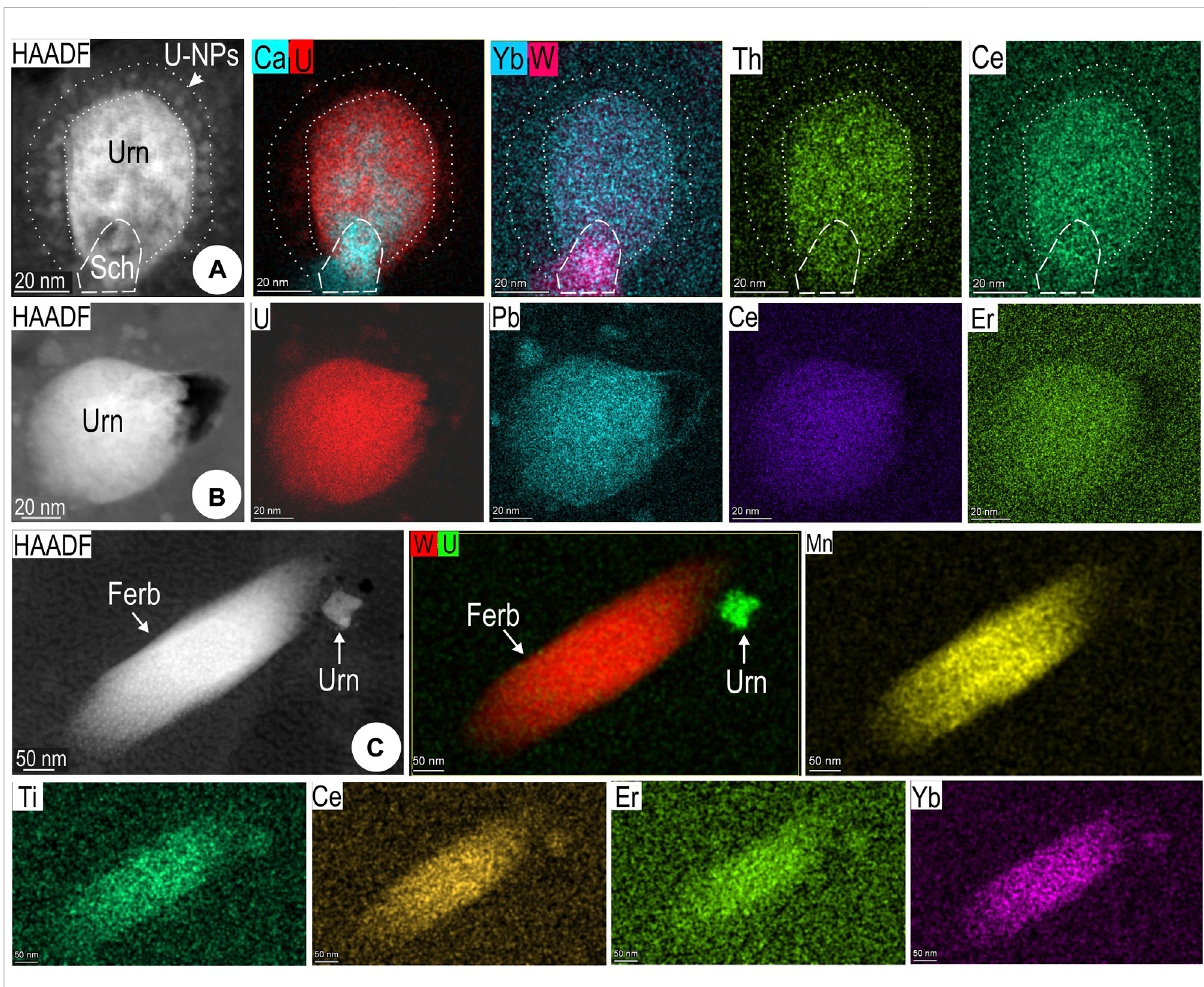
FIGURE 7 Images and selected STEM EDS element maps for U-W-bearing NPs in hematite from sample CLC21 (maps 10 – 12; foils Hm#1 – 3). (A) Multi- component nanoinclusion (shown in Figure 4J) comprising uraninite (Urn) and scheelite (Sch) with halo of sub-nm-scale uraninite. (B) Single, bleb- shapeduraniniteNP,and (C) lamellae offerberite(Ferb). Notethat uraninite, scheelite,and ferberiteall contain REEs(both LREEs, representedbyCe, and HREEs, represented here by Er and/or